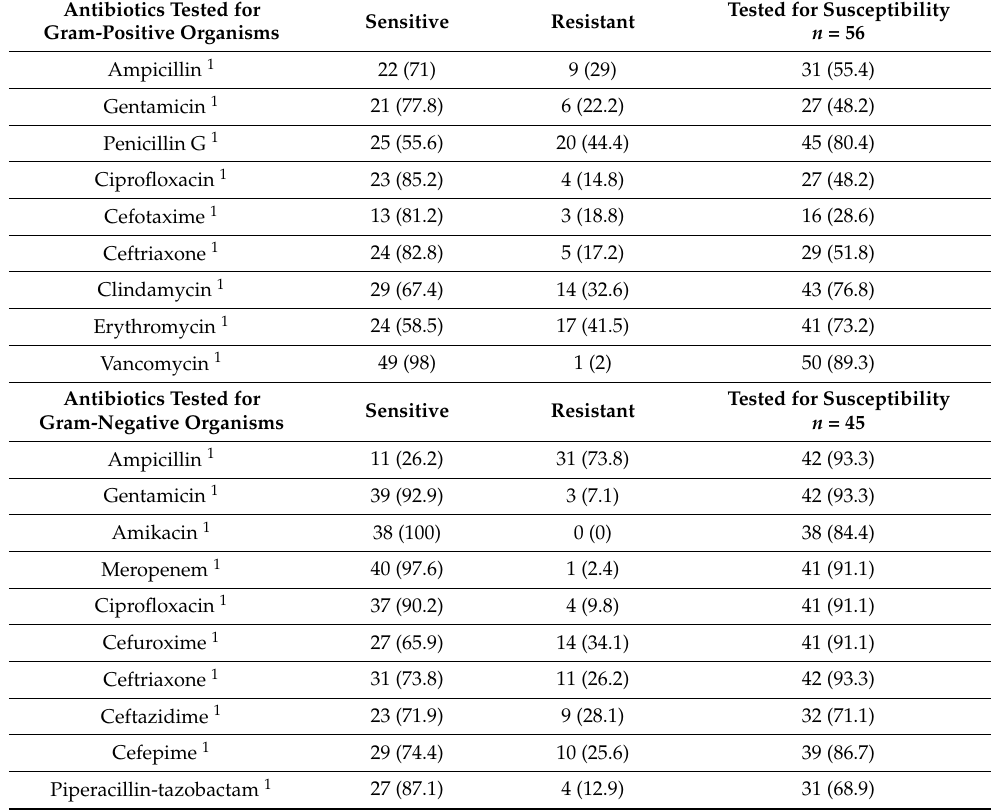
Table 7. Commonly tested antibiotics for